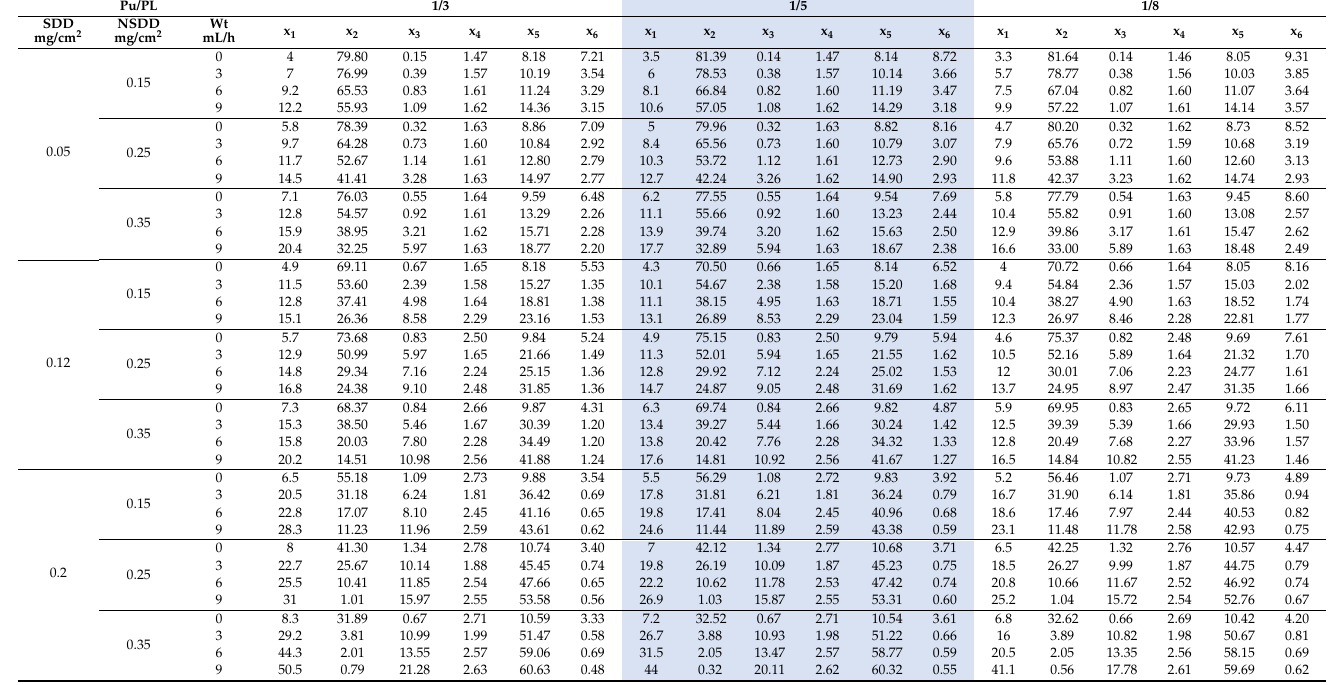
Table 5. LC indices of nonuniformly polluted insulators under different Wt and NSDD for insulator string 33